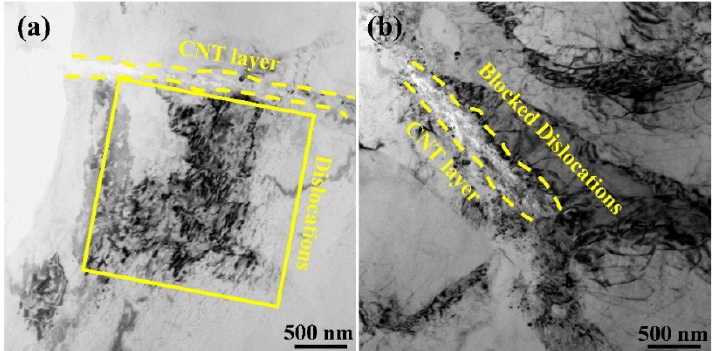
Figure 8. TEM images of 0.5 wt.% CNTs/Mg composites. ( a ) shows the dislocations blocked by the CNT layer after hot extrusion, highlighted by the yellow box; ( b ) accumulated dislocations around the CNT layer after tensile test. The dashed line shows the position of the CNT